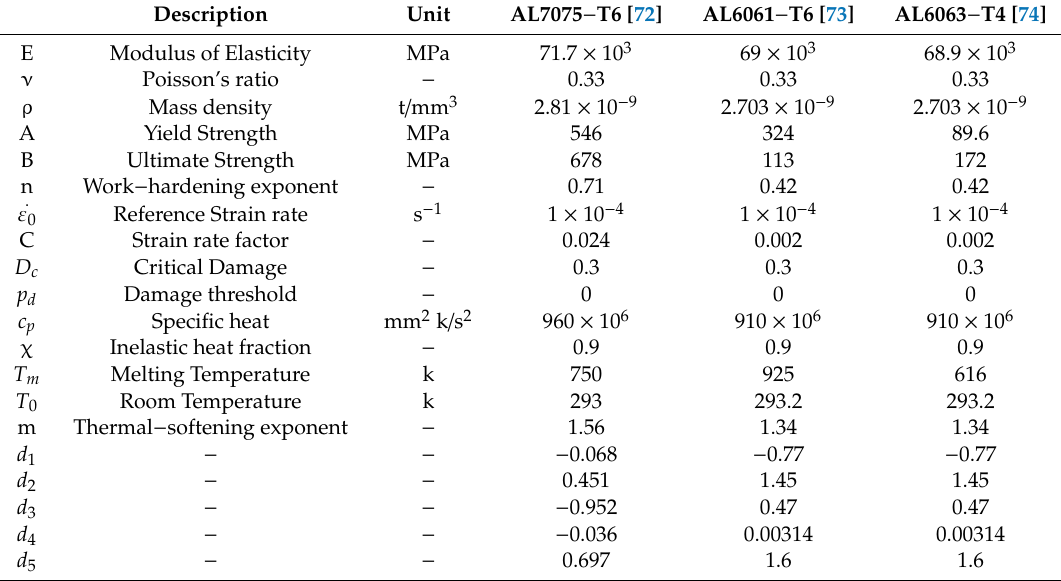
Table 3. Material parameters of the three aluminium grades used in the UGAD auxetic